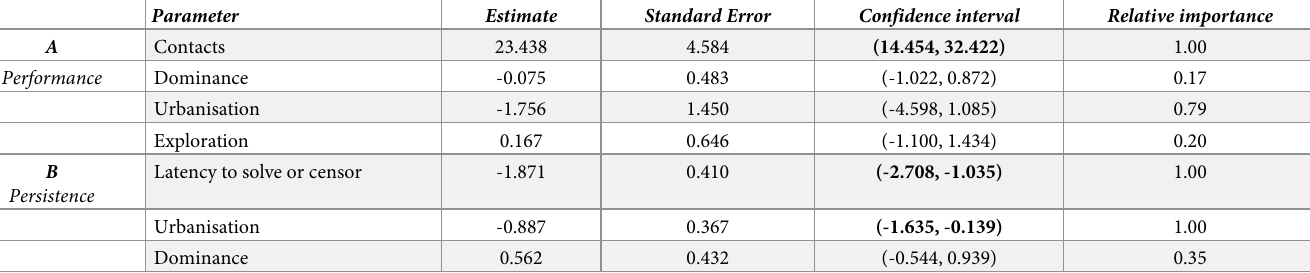
Table 2. Model averaged estimates assessing the influence of predictors on (A) paper-ripping performance (n = 33 individuals, solutions = 17), (B) persistence in the paper-ripping task (n = 36